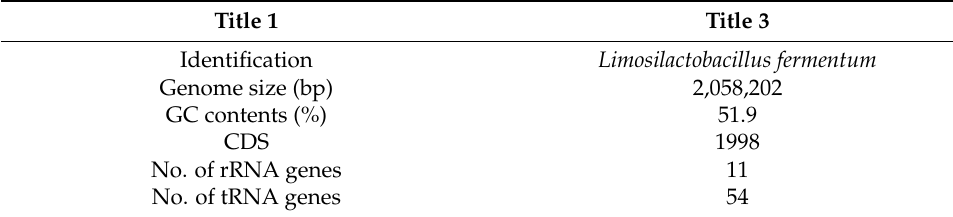
Table 2. Genomic characteristics of L. fermentum